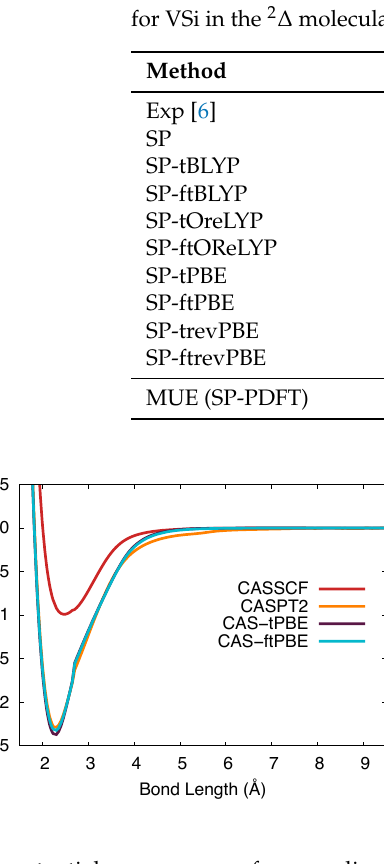
Figure 4. The potential energy curve for vanadium silicide in the 4 Π ground state. ( Left ): CASSCF (red), CASPT2 (orange), CAS-tPBE (purple), CAS-ftPBE (blue). ( Right ): Computed with SP (red), SP-tPBE (purple), SP-ftPBE (blue), and CASPT2